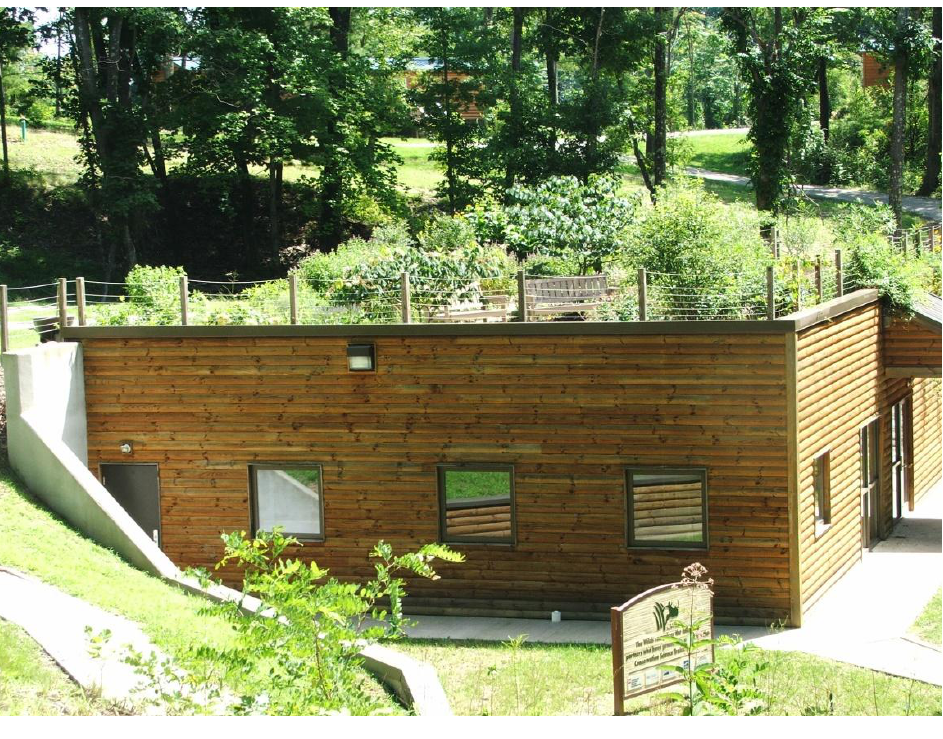
Figure 6. A well-established roof garden at The Wilds, Muskingum County, Ohio,